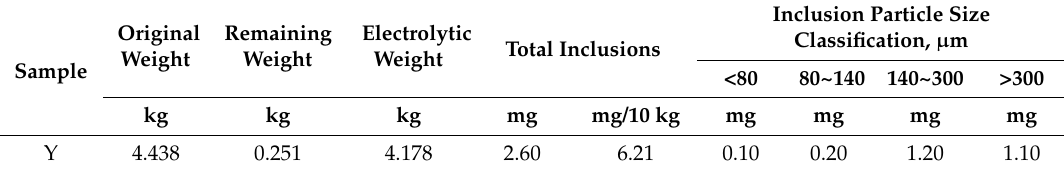
Table 3. Analysis results of large inclusions in steel.